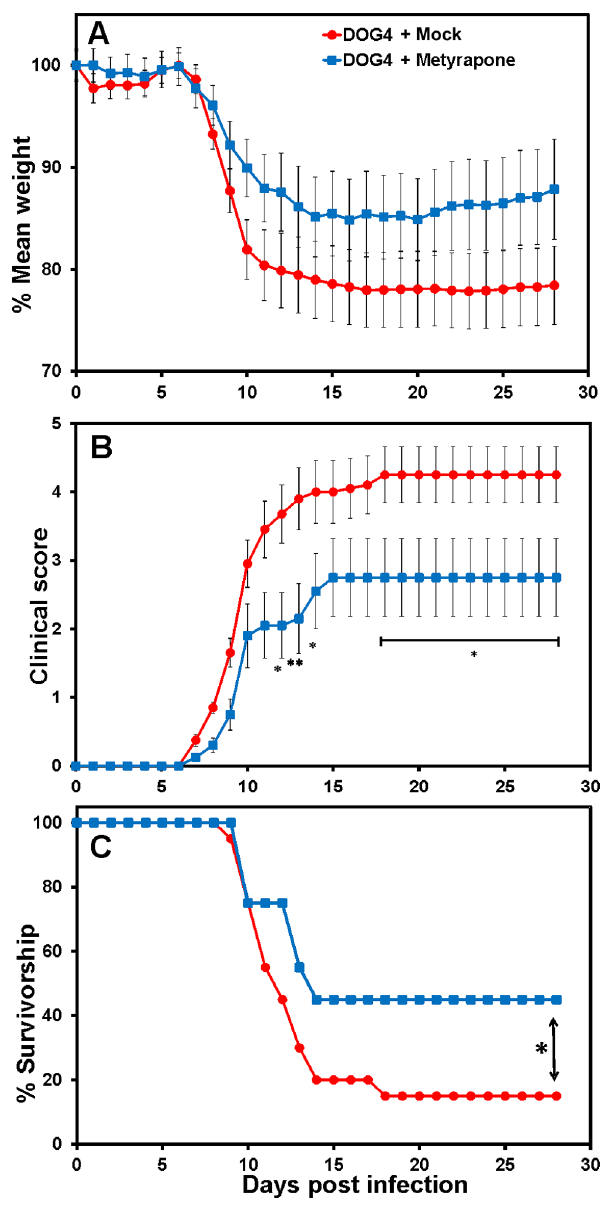
Figure 7. PET with metyrapone, a corticosterone synthesis inhibitor, reduces the pathogenicity of WT RABV. Groups of 20 mice were infected with 10 4 FFU of DOG4 RABV i.n. and either mock- treated with PBS or treated with metyrapone (100 mg/kg) i.p. each day for 21 days. The mice were observed for 4 weeks, and body weight (A), clinical signs (B) and survival (C) are presented ( + / 2 SE). For (A), two- way anova was used to determine significance effects in treatment per day. (B) Two-way anova and Bonferroni post hoc tests were used to indicate daily differences in clinical severity (*p , .05, **p , .01). (C) The Mantel-Cox log-rank test was used to determine differences in survivorship (*p , .05).